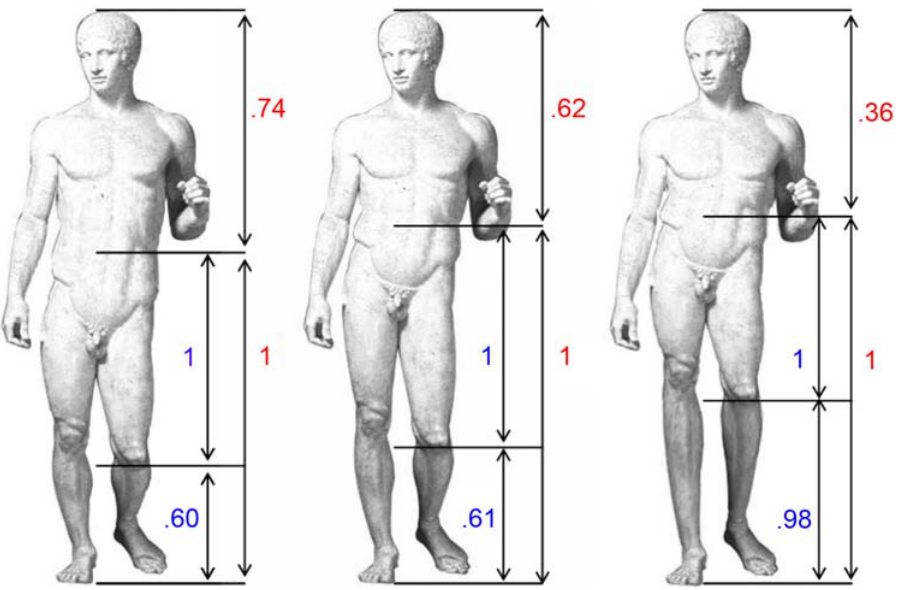
Figure 1. Example of canonical and modified stimuli. The original image (Doryphoros by Polykleitos) is shown at the centre of the figure. This sculpture obeys to canonical proportion (golden ratio=1:1.618). Two modified versions of the same sculpture are presented on its left and right sides. The left image was modified by creating a short legs:long trunk relation (ratio=1:0.74); the right image by creating the opposite relation pattern (ratio=1:0.36). All images were used in behavioral testing. The central image (judged-as-beautiful on 100%) and left one (judged-as-ugly on 64%) were employed in the fMRI study.